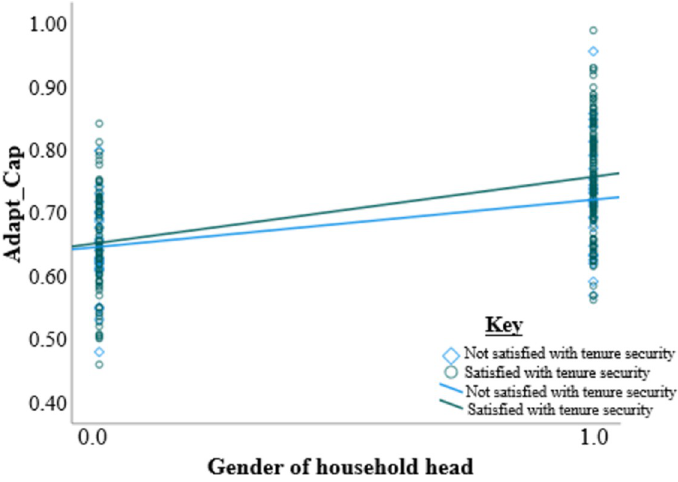
Fig 3. The interaction between gender and land tenure security (all other factors controlled).